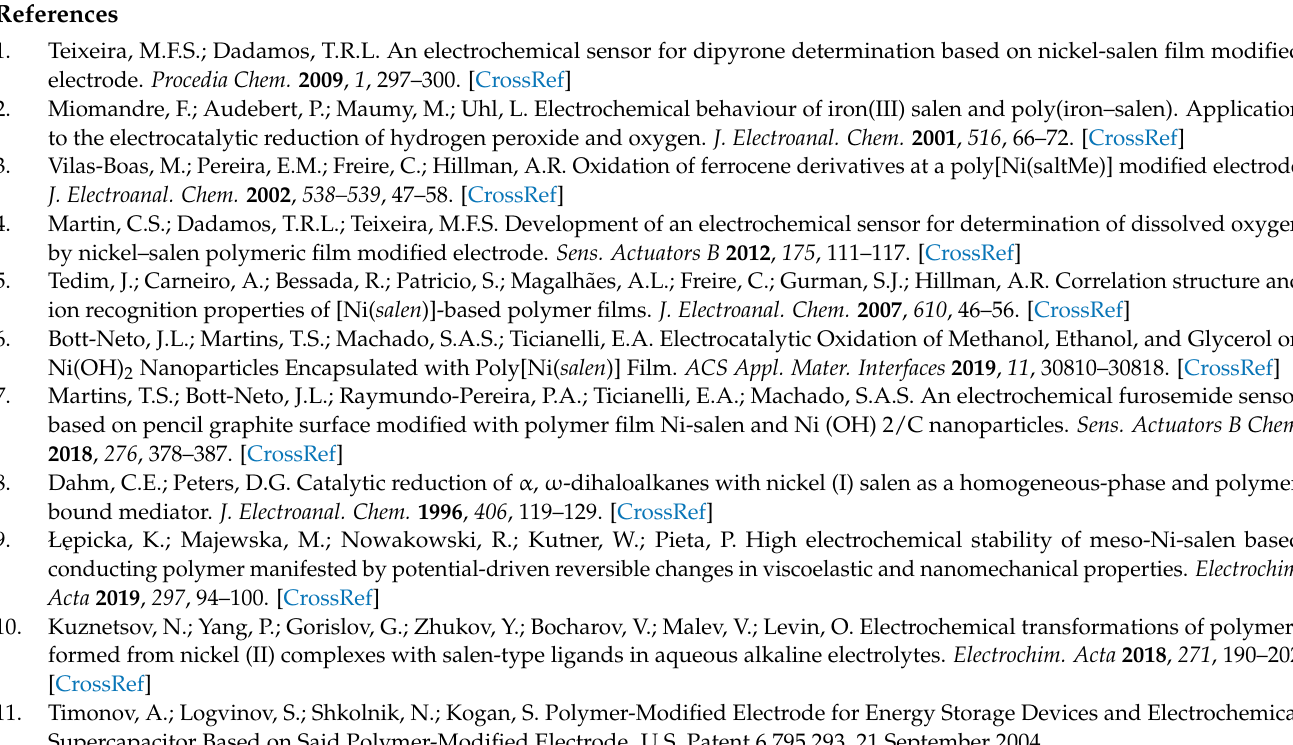
(B) plots ip vs. v1/2 for Ist oxidation step of the process; (C) plots ip vs. v1/2 for IInd oxidation step of the process and Ist reduction step. Figure S20. Cyclic voltammograms of poly[Ni(salcn)], 1st–10th cycle, in TBABF4/CH2Cl2, Pt, v = 0.05 V · s − 1 , vs. Ag/AgCl; after 5 electropolymerization cycles. Figure S21. Cyclic voltammograms of poly[Ni(salcn(Bu))], 1st–10th cycle, in TBABF4/CH2Cl2, Pt, v = 0.05 V · s − 1 , vs. Ag/AgCl; after 5 electropolymerization cycles. Figure S22. Poly[Ni(salcn)] (3 electropolymerization cycles) in TBAClO4/MeCN, Pt, v = 0.01–1 V · s − 1 , vs. Ag/AgCl; (A) the lower part—cyclic voltammograms, the upper part—voltammograms for v = 0.01–0.25 V · s − 1 ; (B) plots ip vs. v1/2 for oxidation and reduction processes. Figure S23. Poly[Ni(salcn)] (3 electropolymerization cycles) in TBABF4/MeCN, Pt, v = 0.02–1 V · s − 1 , vs. Ag/AgCl; (A) cyclic voltammograms; (B) plots ip vs. v1/2 for Ist oxidation step of the process and IInd reduction step; (C) plots ip vs. v1/2 for IInd oxidation step of the process and Ist reduction